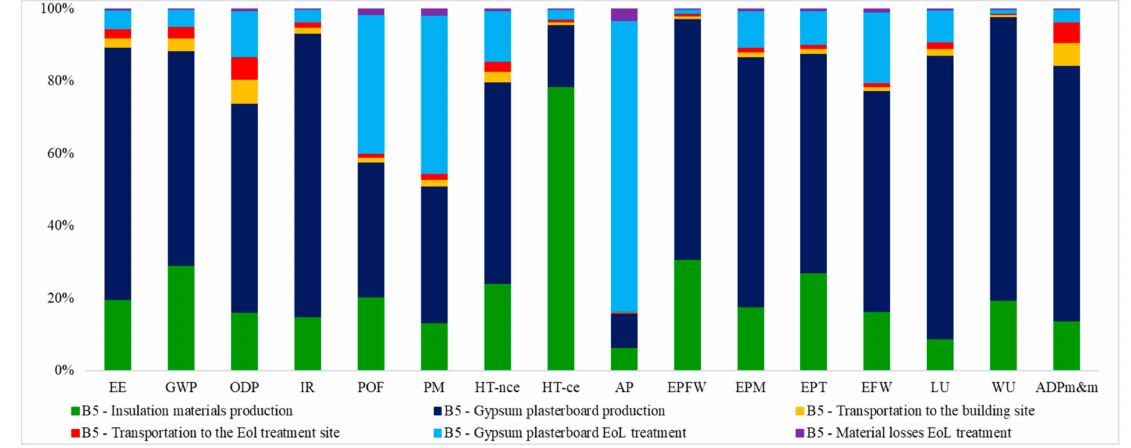
Figure A4. Contribution of the different life cycle phases to the B5 module impacts—SwS